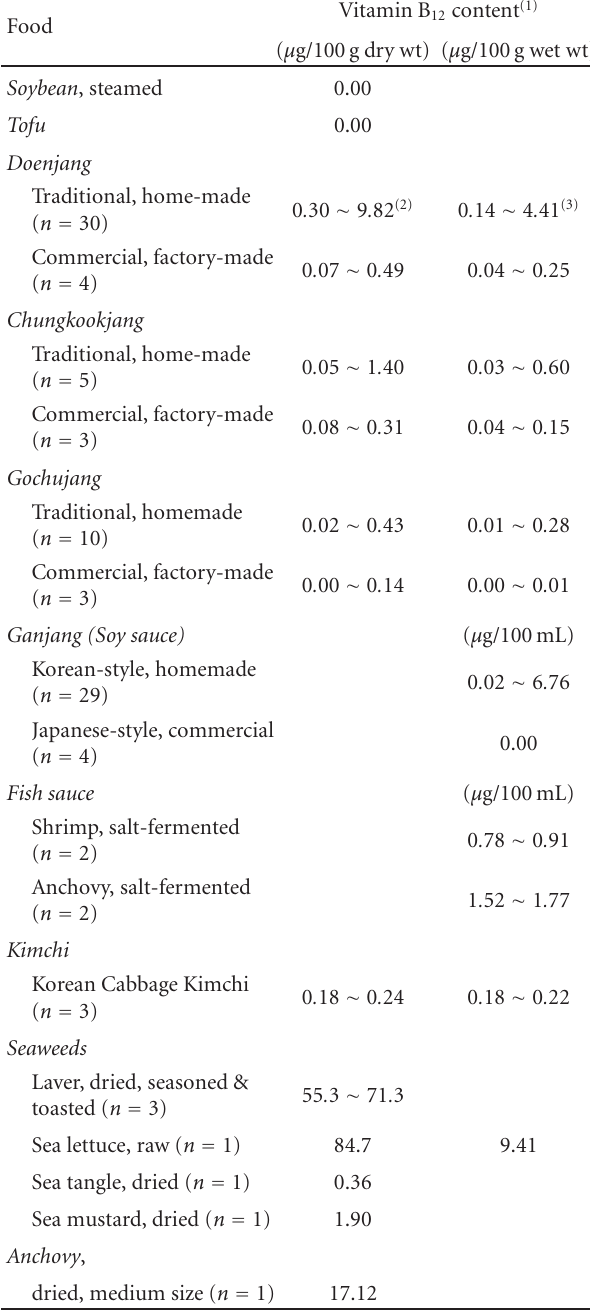
Table 5: Vitamin B 12 content in Korean fermented foods and some popular foods. †